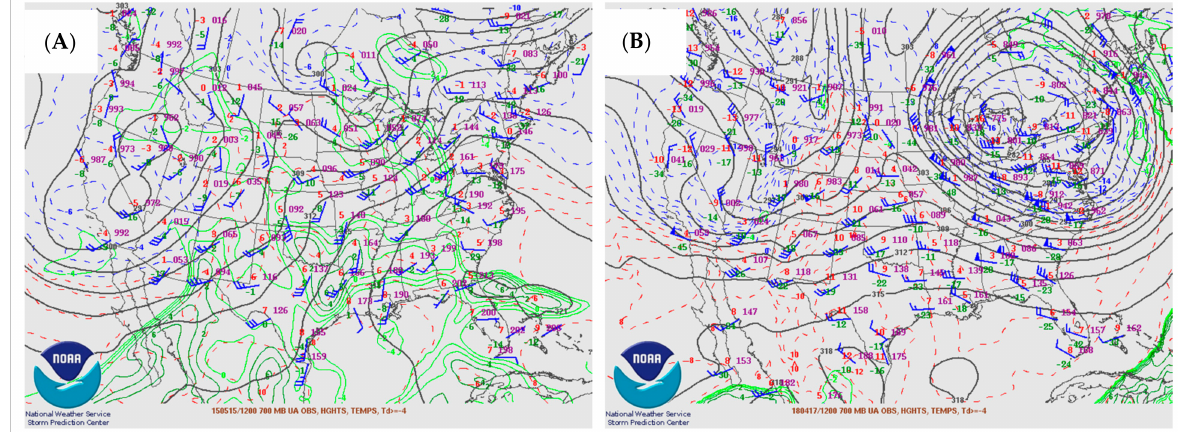
Figure 7. National Oceanic and Atmospheric Administration (NOAA) 700 mbar upper air observation maps. ( A ) 15 May 2015 at 1200 UTC. ( B ) 17 April 2018 at 1200 UTC. Table 3. Cases selected for study based on synoptic conditions at 700 mbar (~1400 m agl). Case WD ( ◦ ) U